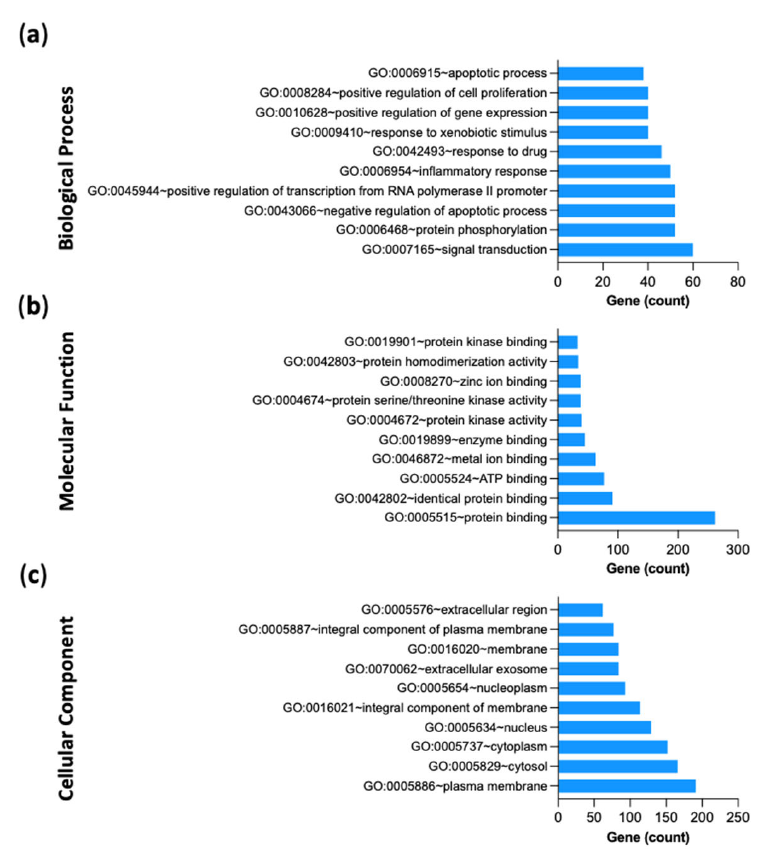
Figure 6. Gene Ontology (GO) analyses. ( a ) Biological process. ( b ) Molecular function. ( c ) Cellular component.